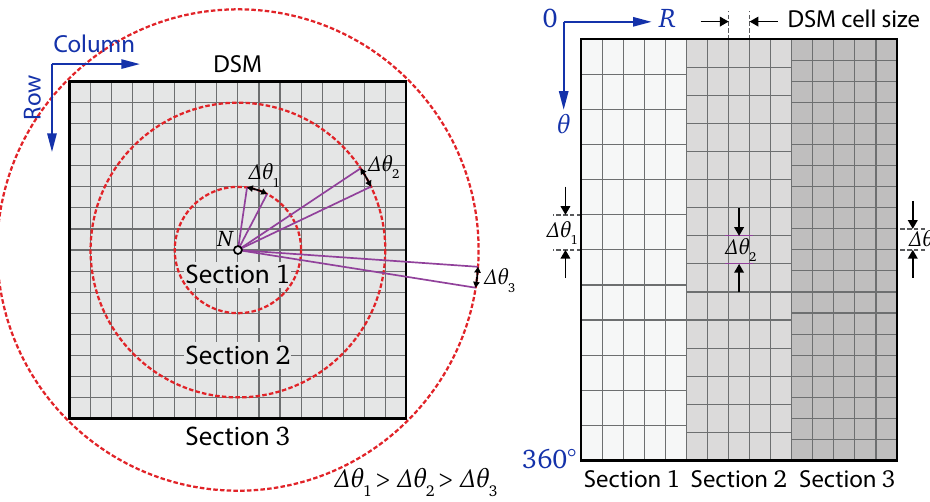
Figure 9. Conceptual details of DSM partitioning within the adaptive radial sweep